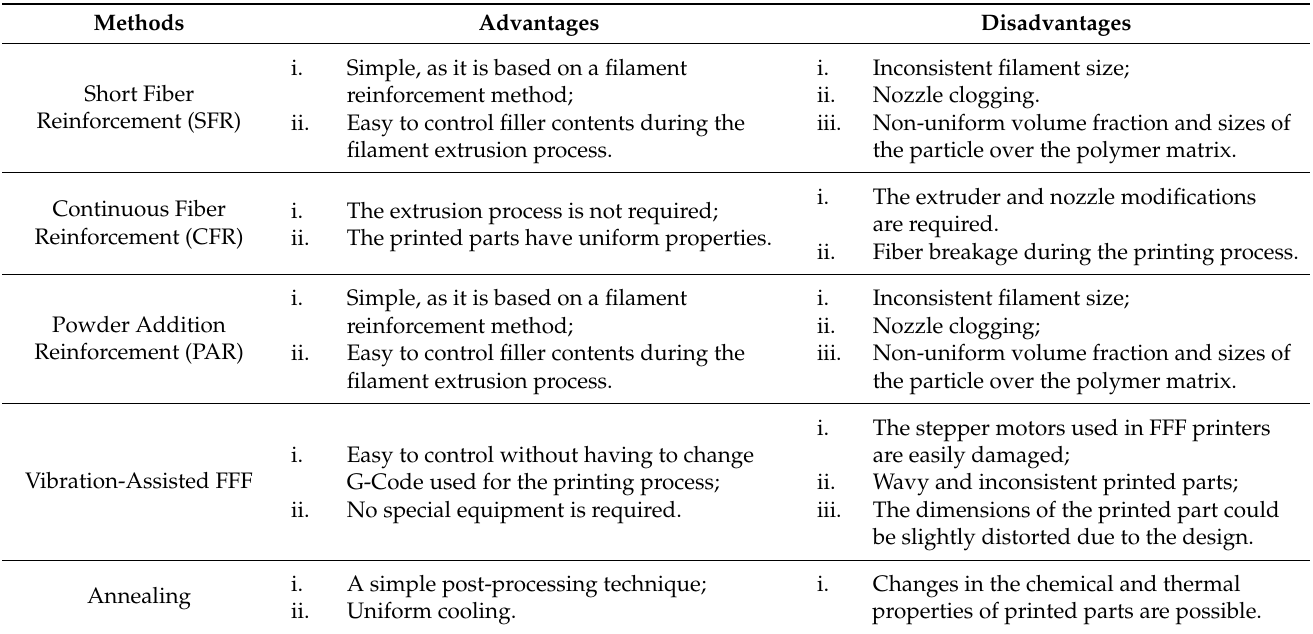
Table 7. The advantages and disadvantages of each reinforcement